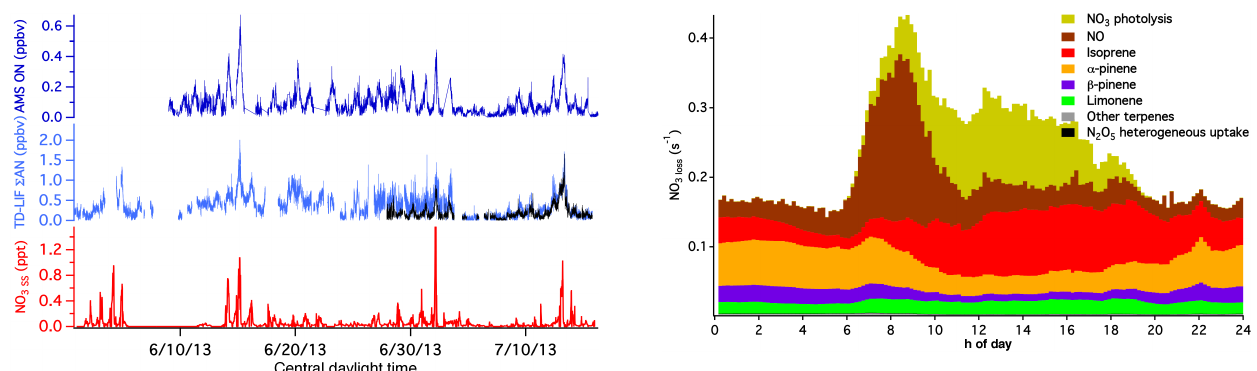
Figure 4. Average diurnal profile of NO 3 / N 2 O 5 losses 1 June– 15 July 2013. NO and photolysis losses peak during the daytime (in fact, nighttime NO 3 + NO loss is likely zero, and even [NO] below the instrument detection limits would cause the non-zero rates shown here); however, losses to alkenes are significant dur- ing both night and day Terpene losses are calculated from GC-MS data, NO and N 2 O 5 data are from CRDSs, and photolysis losses are calculated as described in Sect. 3.1. Uncertainties in rate con- stants of BVOCs + NO 3 range from 2% for myrcene to − 40% for β -pinene (Calvert et al., 2000). Uncertainties in rate constants of BVOCs + NO 3 range from ± 30% for α -pinene to up to a factor of 2 for isoprene (Calvert et al., 2000); NO measurements had ± 35% uncertainty, BVOC measurements ± 20%, and photolysis ± 20% based on solar radiation measurement